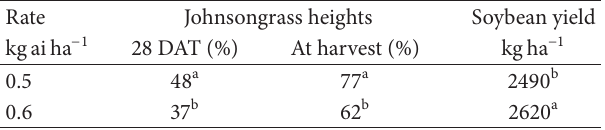
a Data pooled over POST1 glufosinate application rate of 0.5, 0.6, or 0.7kgaiha −1 and POST2 and POST3 sequential glufosinate application timing. b Means followed by the same letter within each column are not significantly different based on Tukey’s HSD at 𝑃 ≤ 0.05